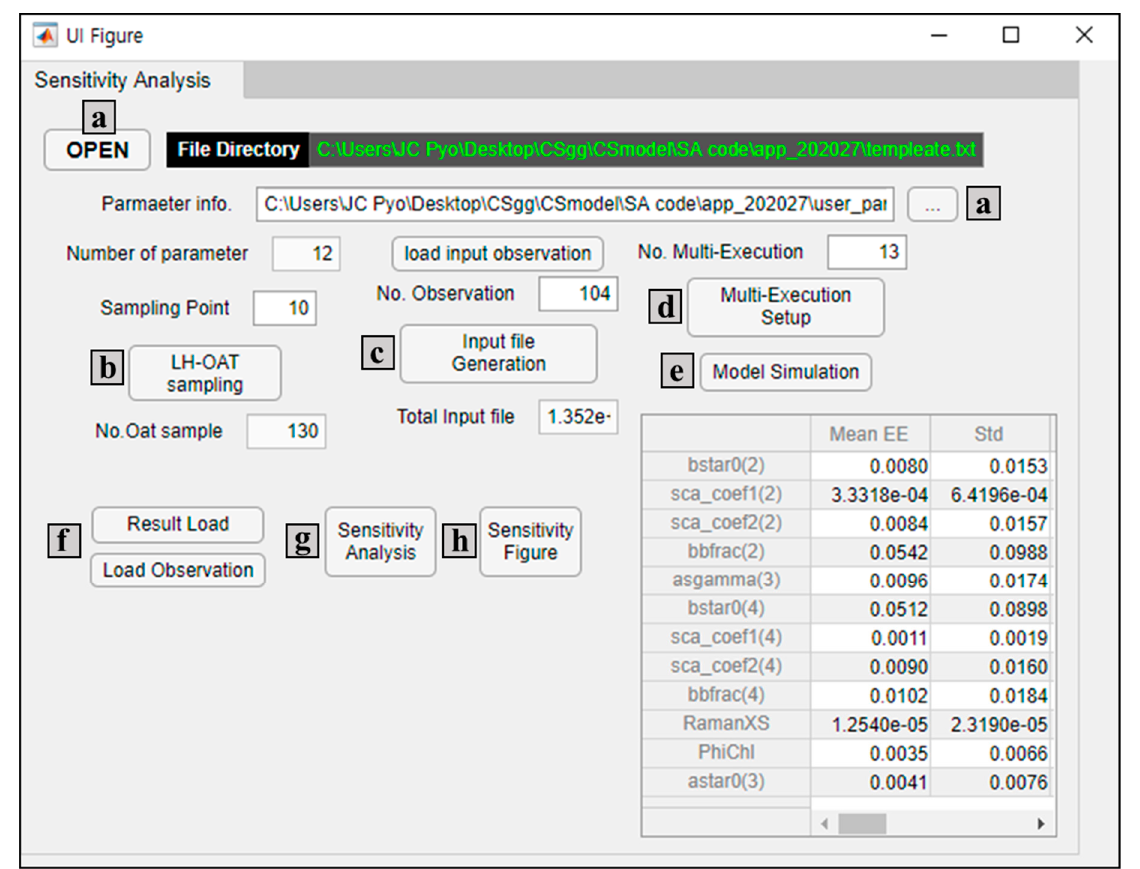
Figure 3. Graphical user interface (GUI) design of HydroLight sensitivity analysis program—( a ) is the implementation button of the loading template for the HydroLight input file and the selected parameter for sensitivity analysis; ( b ) is the switch for implementing the LH–OAT sampling based on the parameters and user-defined sampling points; ( c ) is the button for generating the total number of input files; ( d ) is the button for generating multiple simulation sets; ( e ) is the multiple execution button of the HydroLight simulation; ( f ) is the buttons for loading simulated reflectance results and corresponding observation results; and ( g , h ) are the switches for conducting parameter sensitivity analysis and visualizing the sensitivity analysis results,